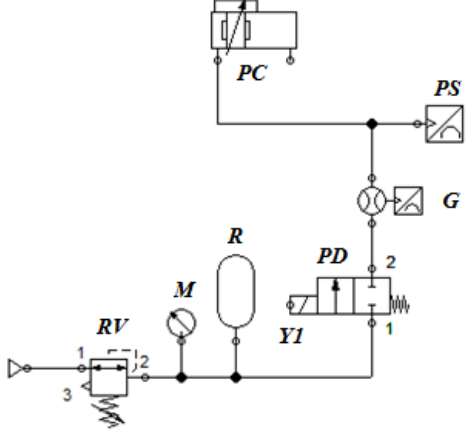
Figure 2. Principle pneumatic diagram of the